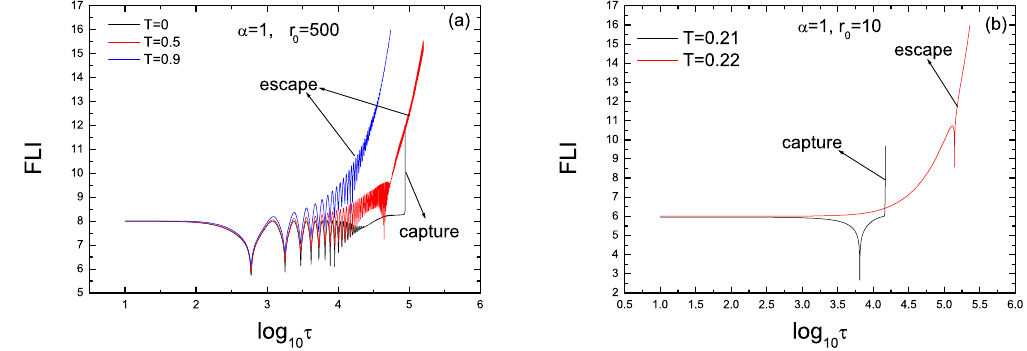
Figure 4 . FLIs for r 0 = 500 (left plot) and r 0 = 10 (right plot) with di(cid:11)erent temperatures T . Here, (cid:11) = 1, z = 1, (cid:18) =